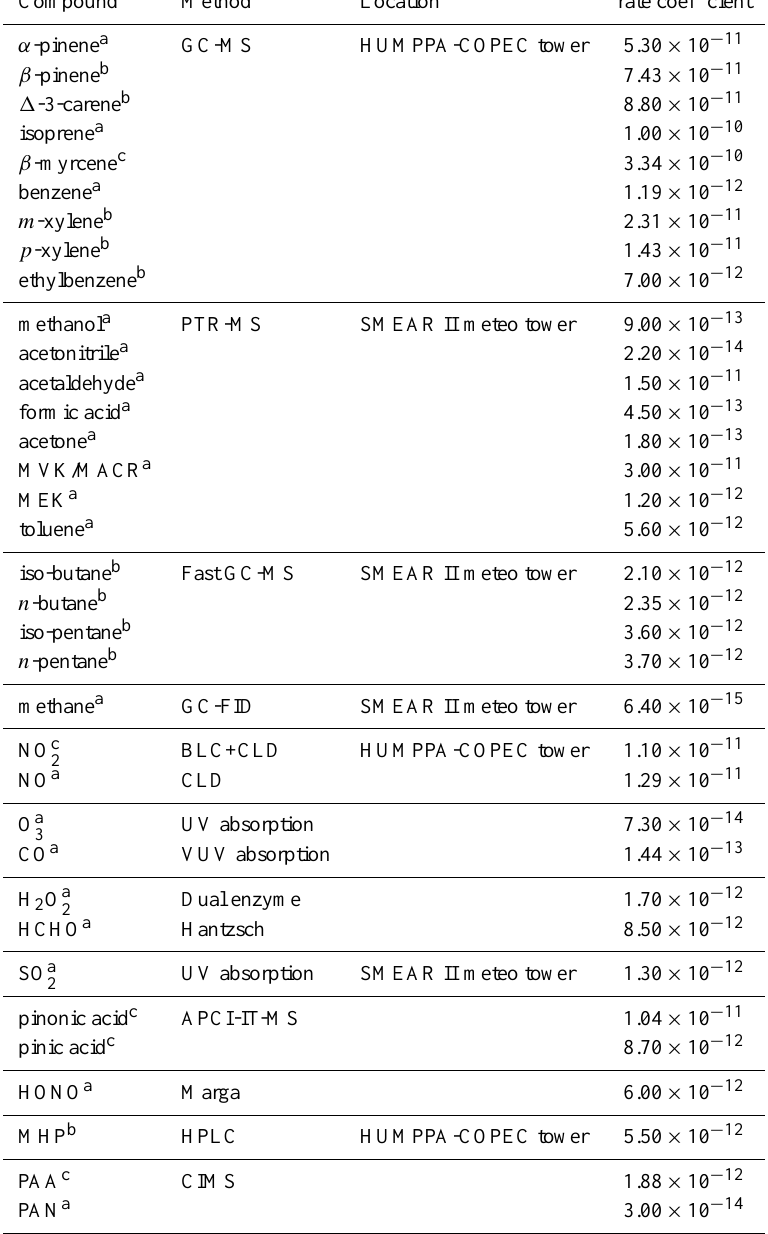
Table 2. Compounds, instruments and locations of the measurements which have been used for the calculation of total OH reactivity. The rate coefficients were taken from the literature and listed here in cm 3 molecules − 1 s − 1